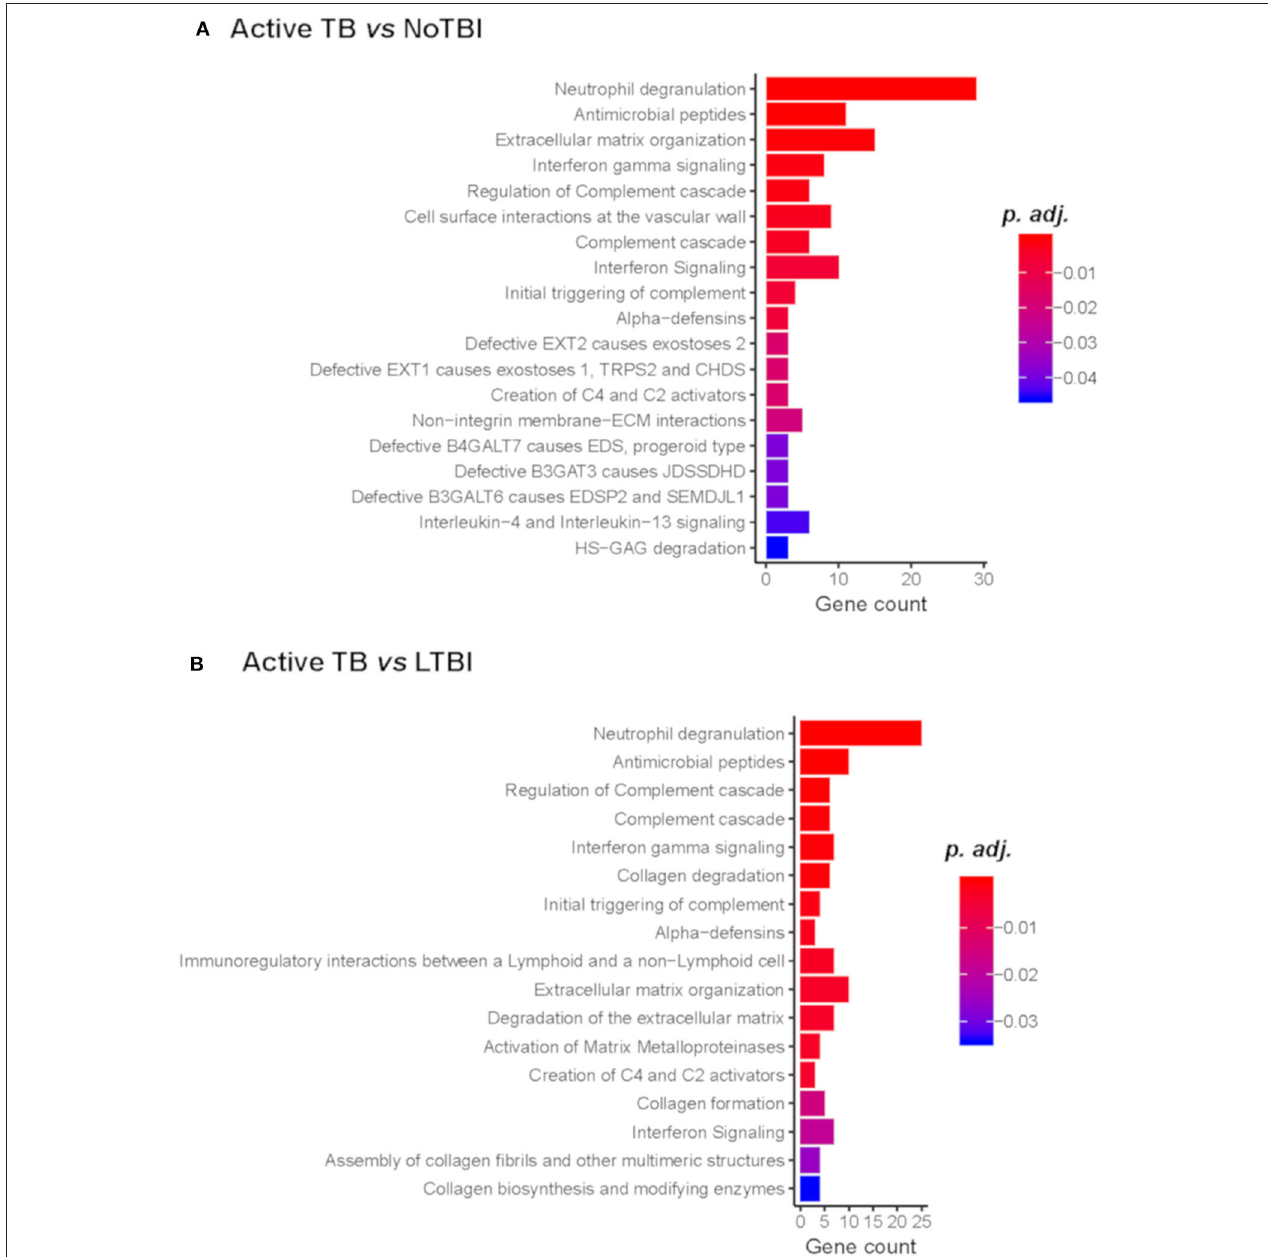
FIGURE 2 | Reactome Pathway Enrichment Analysis of genes differentiating Active TB vs. NoTBI (A) and vs. LTBI (B) . The Gene count indicates the number of genes from the input list found on each pathway. The adjusted p-value (p.adj) indicates the significance of the